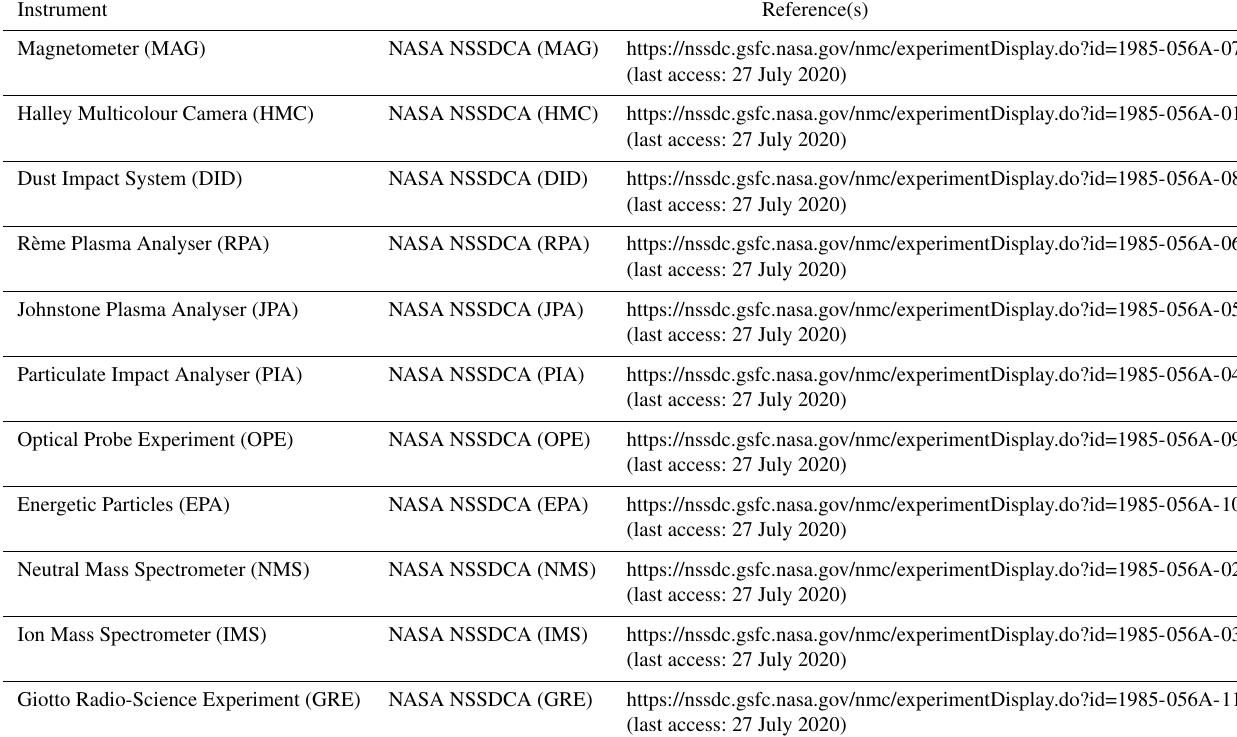
Table A1. Giotto’s instruments and references for team members lists.